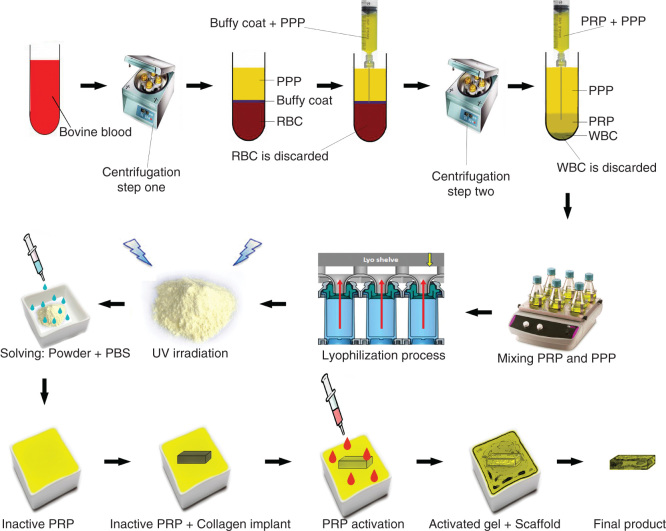

Schematic view of the xenogenous-based bovine-pure PG preparation and its embedding with the CI. Peripheral blood was obtained by i.v. catheterization of the healthy bovine and was transferred to the EDTA tubes. The samples were centrifuged in two steps. After the first-step centrifugation, three layers are formed including PPP, PRP + WBCs = buffy coat and RBCs. The PPP and buffy coat layers were suctioned and transferred into a new tube but the RBCs were discarded. The PPP and buffy coat were centrifuged again (second step centrifugation). This resulted in formation of three layers including PPP, PRP and WBC. WBCs were discarded, but the PPP and PRP were suctioned into the sterile tubes. The solution was mixed and lyophilized to concentrate the platelets and produce a lyophilized platelet powder. The powder was then sterilized by UV irradiation, and it was then solved in sterile phosphate buffer saline to produce the desired concentration (six to seven times more than that of the normal blood concentration). The sterile fully dehydrated three-dimensional CI was immersed in the PRP solution, and the implant was left to absorb the platelets in its architecture. The PRP solution was then activated, using bovine thrombin and CaCl2. Therefore, the absorbed PRP in the CI was activated and the gel was formed in the CI. The final product was a PG embedded within the CI. Each arrow shows a subsequent step.